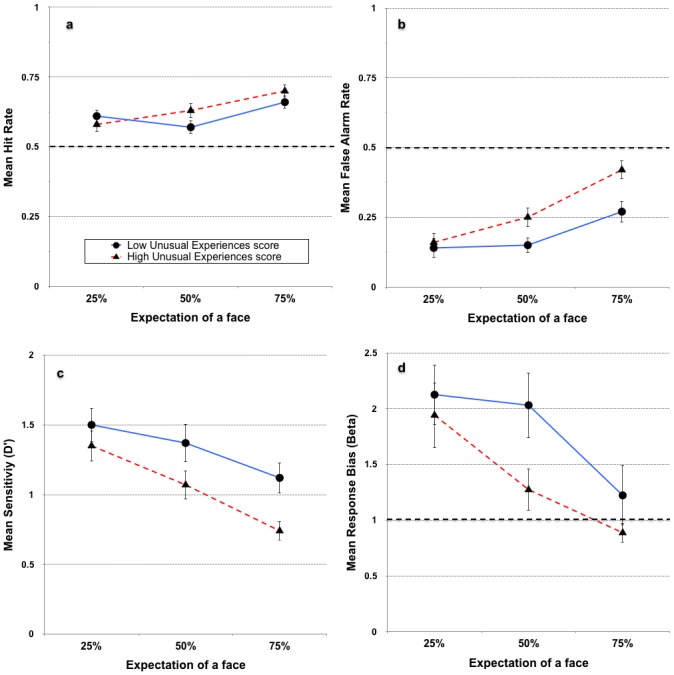
Performance across the different expectation conditions, collapsed across spatial frequency, in the Perception Of Meaning task.Data plotted separately for individuals scoring below and above the median on the UnEx subscale of the O-LIFE (N = 94, error bars represent ±95% confidence intervals). The reference lines in panels a and b represent chance performance (yes-no task), whereas the reference line at β = 1 in panel d represents the point of no response bias for an unbiased responder. A β value less than 1 indicates a bias toward saying a face was present in a noise-only stimulus.